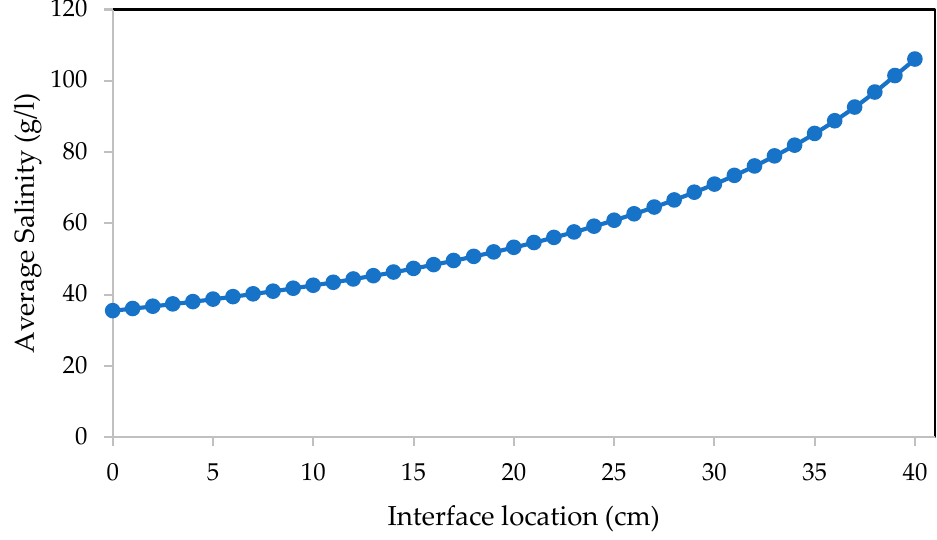
Figure 6. Brine average salinity, depending on interface